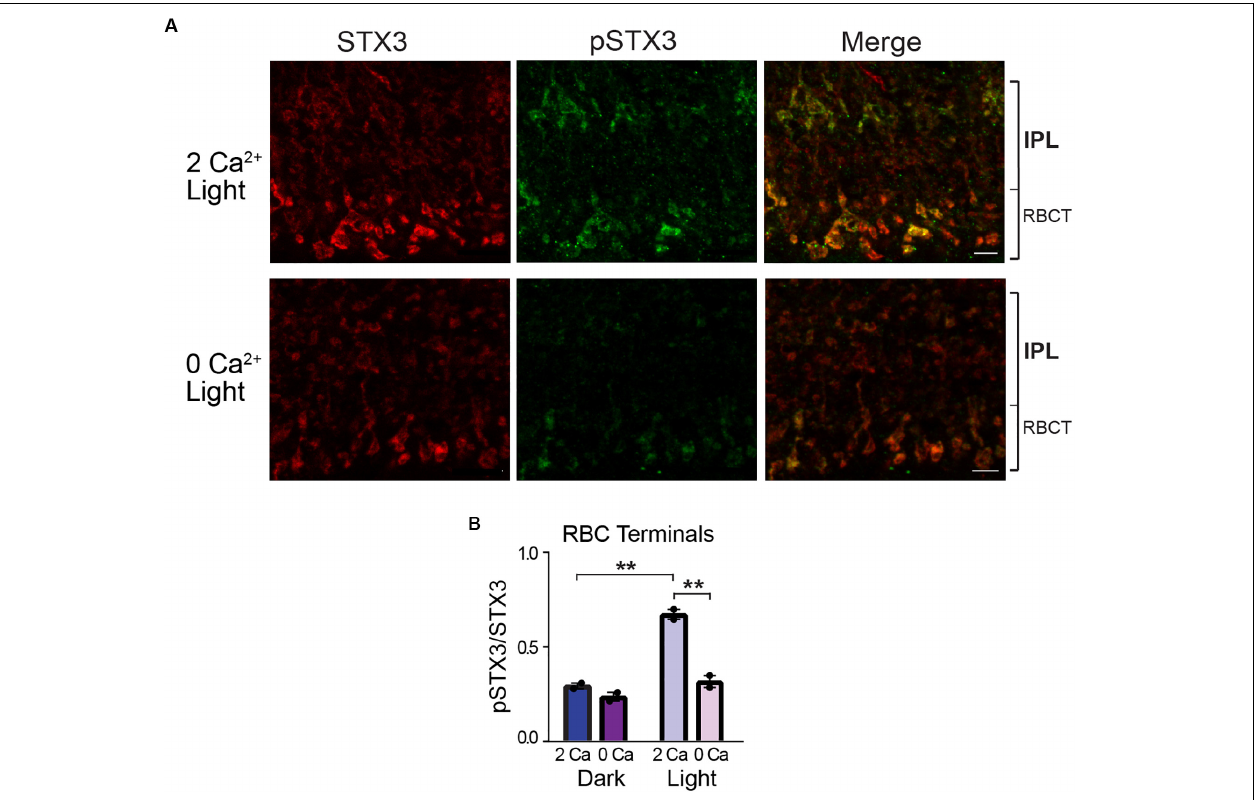
FIGURE 4 | External Ca 2 + is required for STX3 phosphorylation at T14 in rod bipolar cell synaptic terminals. (A,B) A pair of representative confocal images show that phosphorylation of STX3 at T14 in rod bipolar cell synaptic terminals in light-treated retinal eyecups is reduced by the omission of Ca 2 + from the external bath solution (“O Ca”). The small bracket labeled “RBCT” indicates the region of the IPL where the rod bipolar cell terminals reside. Scale bar = 5 µ m. (B) In rod terminals, the pSTX3/STX3 ratio in dark-adapted retinal eyecups was greatly reduced in the absence of external Ca 2 + ( p = 0.0019) and indistinguishable from that of dark-adapted eyecups, with or without external Ca 2 + ; p = 0.9043 and 0.2382, respectively. n = 2,2 (mice). **Indicates p <